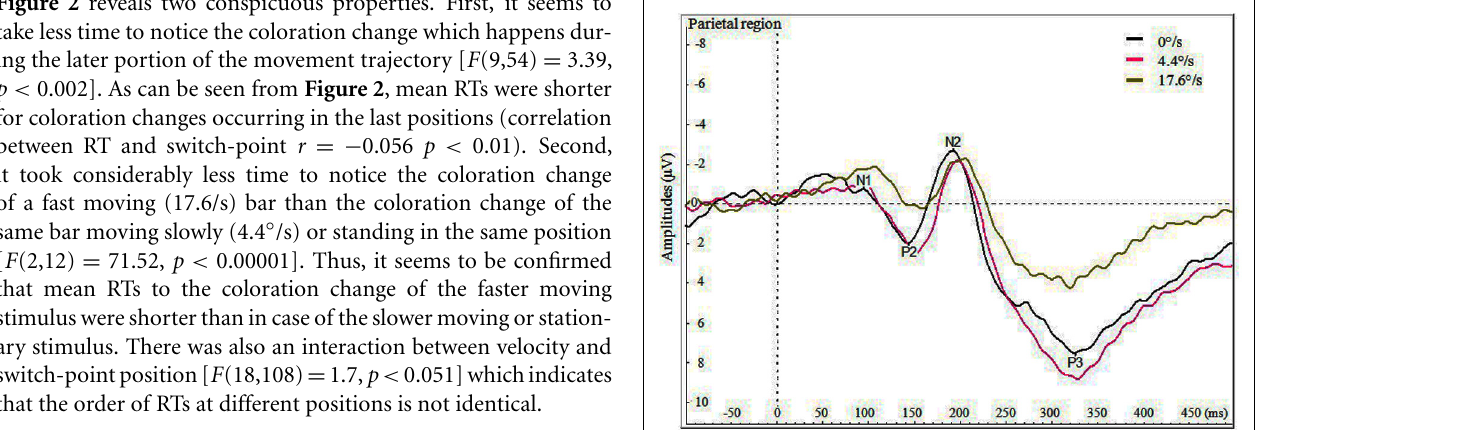
amplitudes for slower moving and stationary stimulus did not differ significantly.